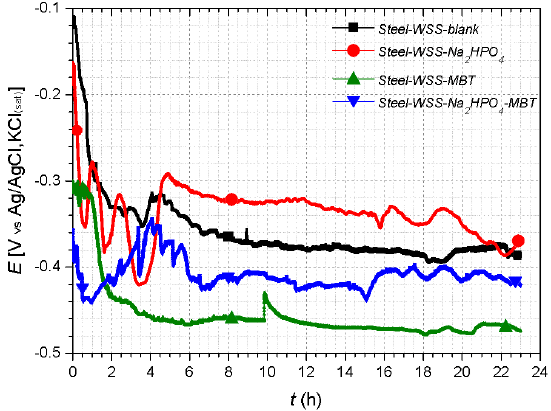
Figure 15. The evolution of open circuit potential (OCP) versus time in case of the mild steel panels submission in WSS for 23 h: ( (cid:4) filled square ) Steel–WSS–blank , ( (cid:8) filled circle ) Steel–WSS–Na 2 HPO 4 , after submission in WSS for 23 h: (  filled square ) Steel–WSS–blank , (  filled circle ) Steel–WSS– ( (cid:78) filled triangleD ) Steel–WSS–MBT , ( (cid:72) filled triangleU ) Steel–WSS–Na 2 HPO 4 –MBT . Na 2 HPO 4 , (  filled triangleD ) Steel–WSS–MBT , ( ▼ filled triangleU ) Steel–WSS–Na 2 HPO 4 –MBT .